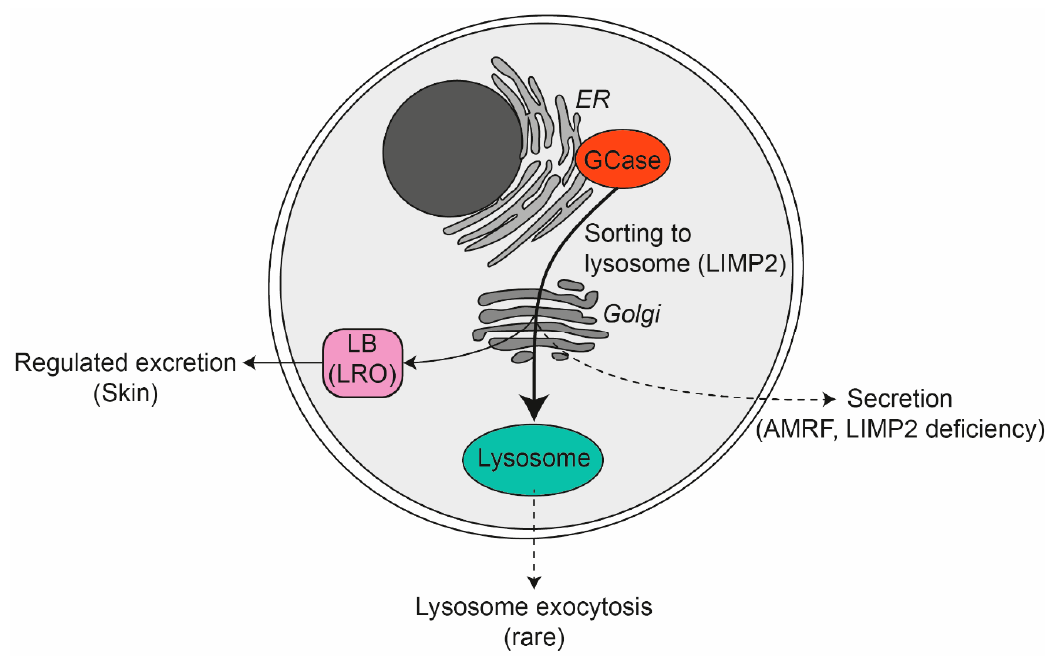
Figure 3. The life cycle of GCase in and beyond the lysosome. AMRF: Action myoclonus renal failure syndrome, ER: endoplasmic reticulum, LB: lamellar body, LIMP2: lysosomal membrane protein 2LRO: lysosome related organelle.